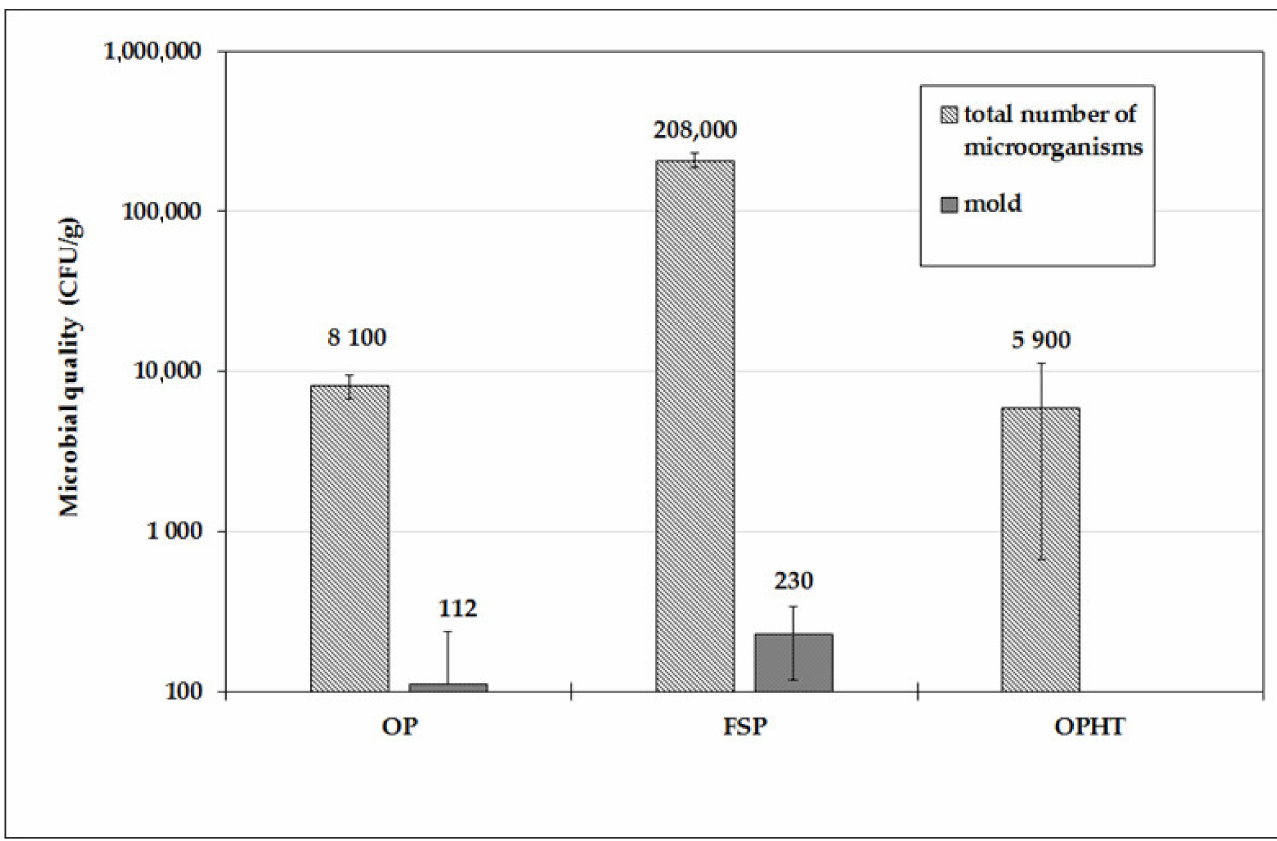
Figure 4. Microbial qualities in variously prepared from OP, FSP, and OPHT lyophilized